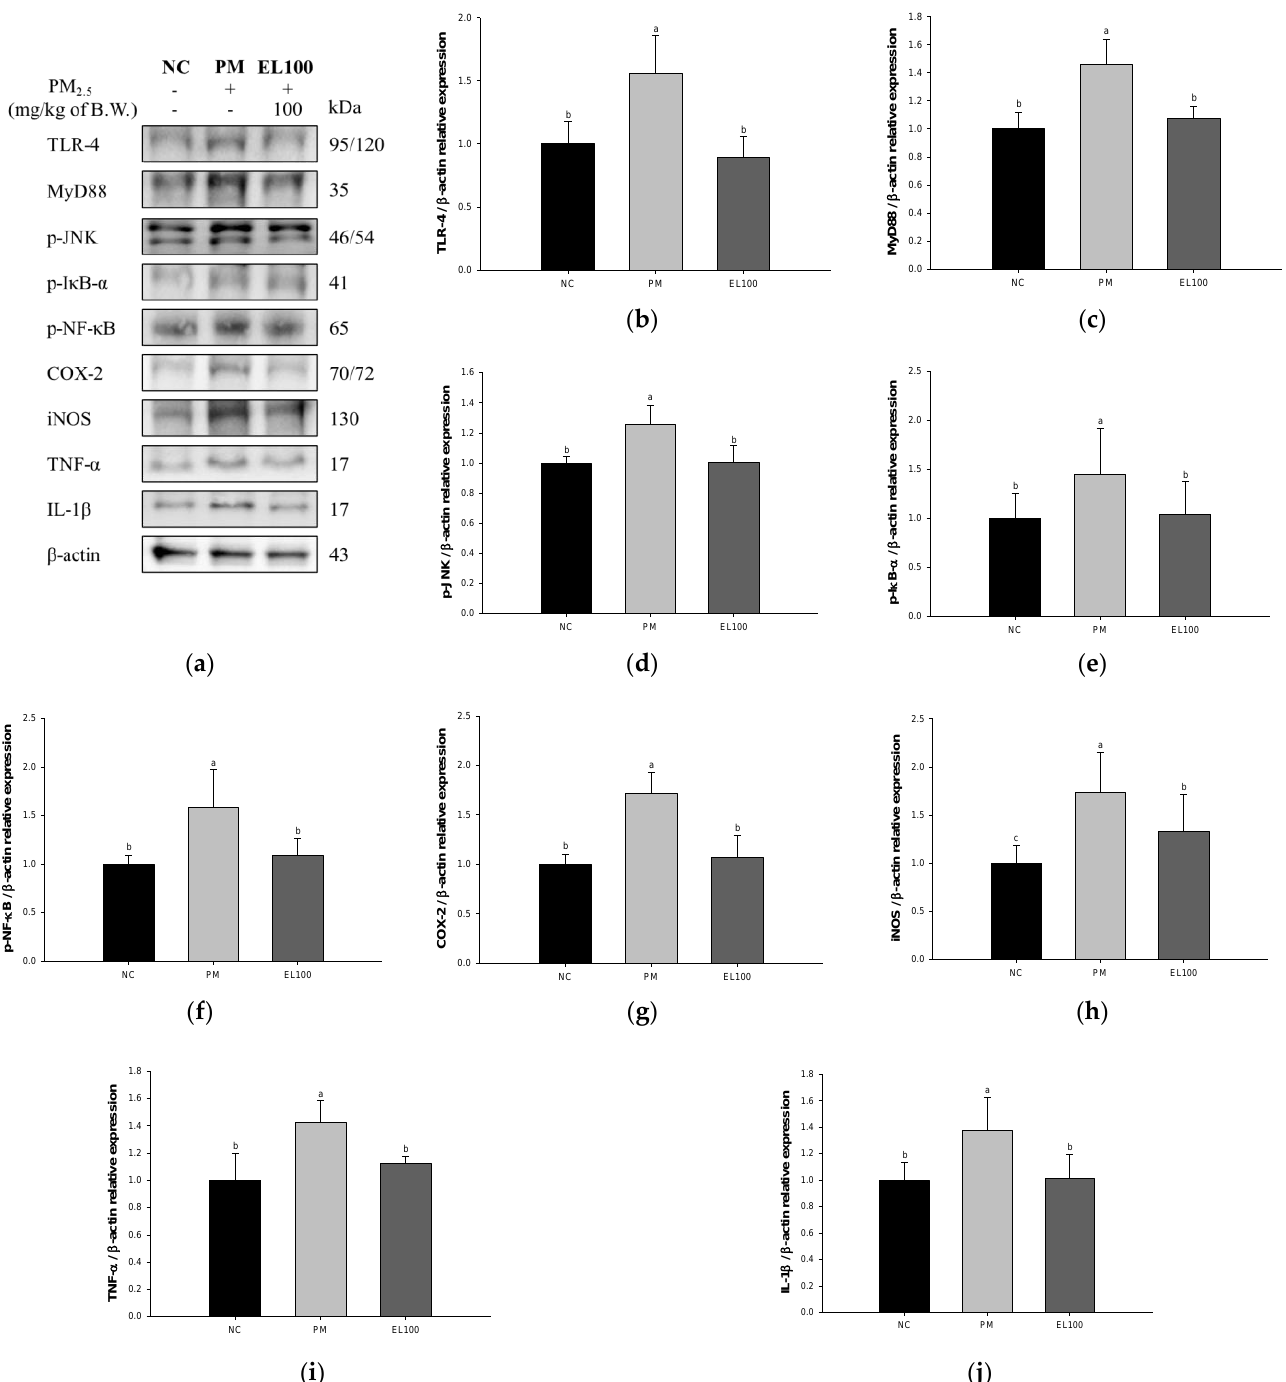
Figure 6. Protective effect of extract of Lonicera japonica on PM 2.5 -induced protein expression of West- ern blot images ( a ). Protein expression levels of TLR-4 ( b ), MyD88 ( c ), p-JNK ( d ), p-NF-κB ( e ), p-NF- κB ( f ), COX-2 ( g ), iNOS ( h ), TNF-α ( i ), and IL-1β ( j ). Results shown are mean ± SD ( n = 3). Data were statistically represented at p < 0.05, and different lowercase letters indicate statistical significance.